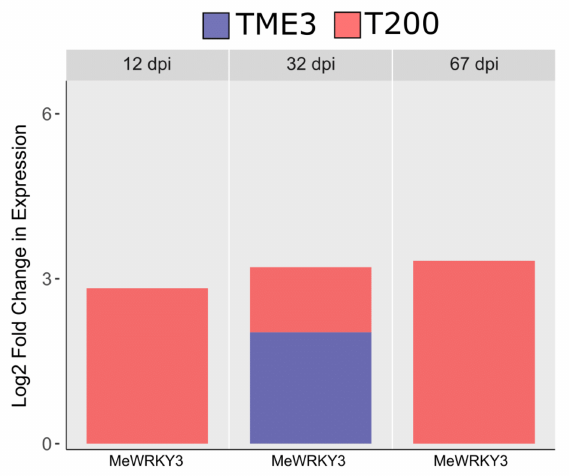
Figure 3. Log2 fold change in expression of MeWRKY 3 at 12, 32 and 67 days post infection (dpi) with South African cassava mosaic virus .